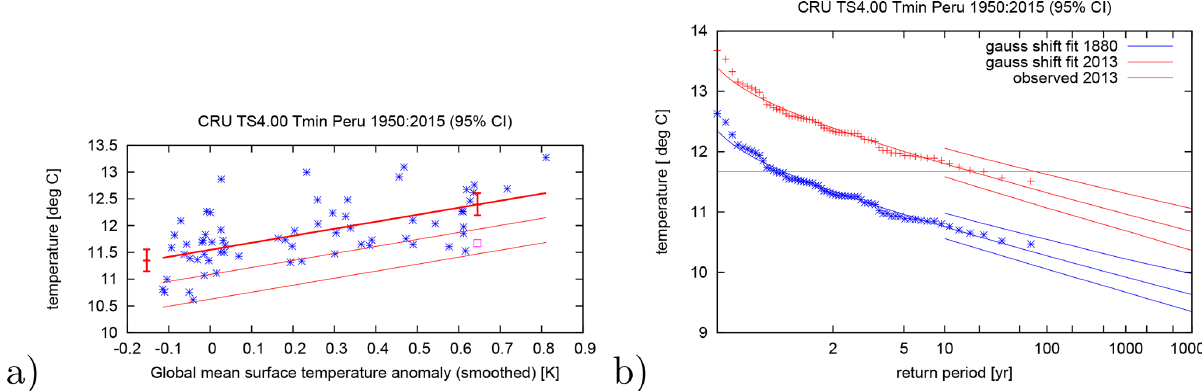
Figure 4. Fit of the minimum temperatures averaged over June–August and Peru. A normal distribution is used that shifts with the global mean surface temperature. The distribution is evaluated for the climates of 1880 and 2013. (a) June–August minimum temperatures against the change in GMST. The thick line denotes the time-varying mean and the thin lines are 1 σ and 2 σ below, respectively. The purple square shows the 2013 value, which was not used in the fit, and the two vertical red lines show the 95% confidence interval of µ for the climates of 1880 and 2013. (b) Return periods for the 2013 climate (red lines) and the 1880 climate (blue lines with 95% CI). Observations are shown twice, once shifted up to the climate of 2013 with the fitted trend (red signs), once shifted down to 1880 (blue signs). After Otto et al. (2018b), reproduced on the Climate Explorer at https://climexp.knmi.nl (last access: 2 December